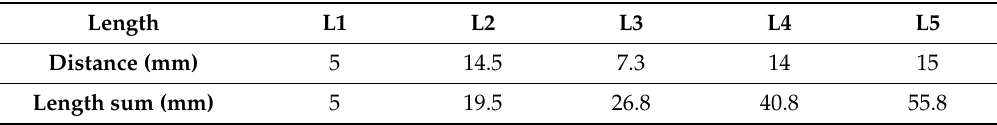
Figure 1. Test part geometry. Table 1. Section dimensions for the test part.